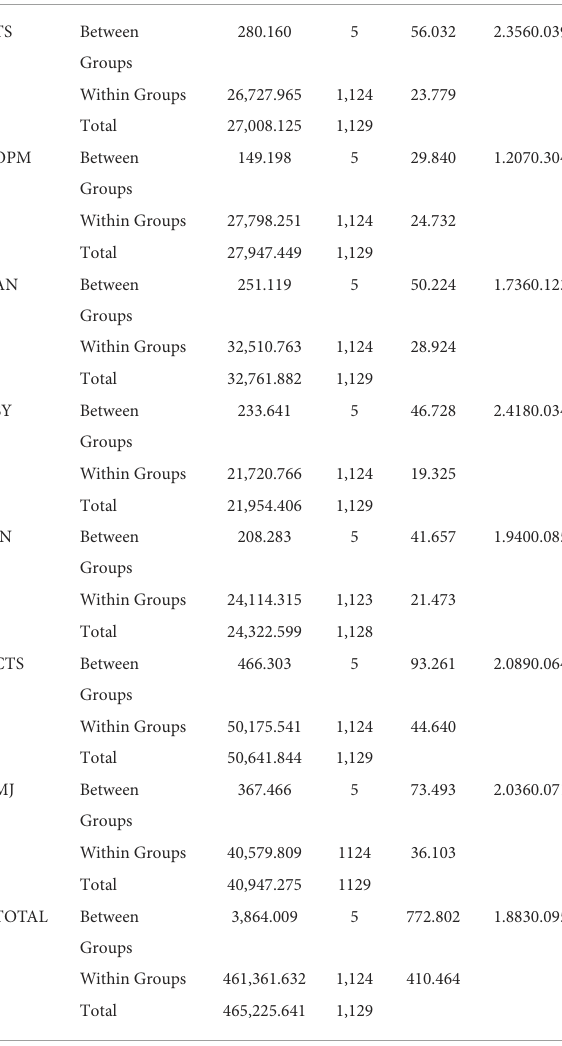
TABLE 4 Summary of results regarding ANOVA analysis of critical thinking disposition levels of participants in terms of their regions. Variables Sum of squares df Mean square F